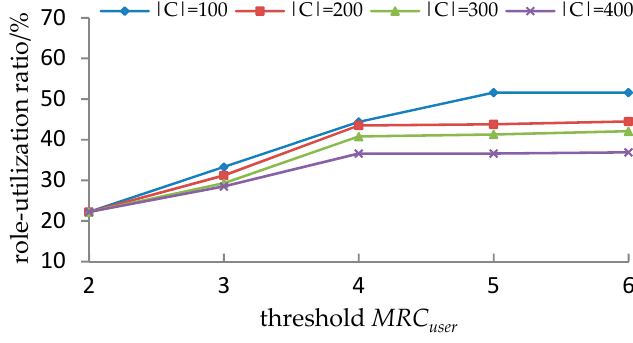
Figure 7. Performance of our method with a di ff erent MRC user and C .